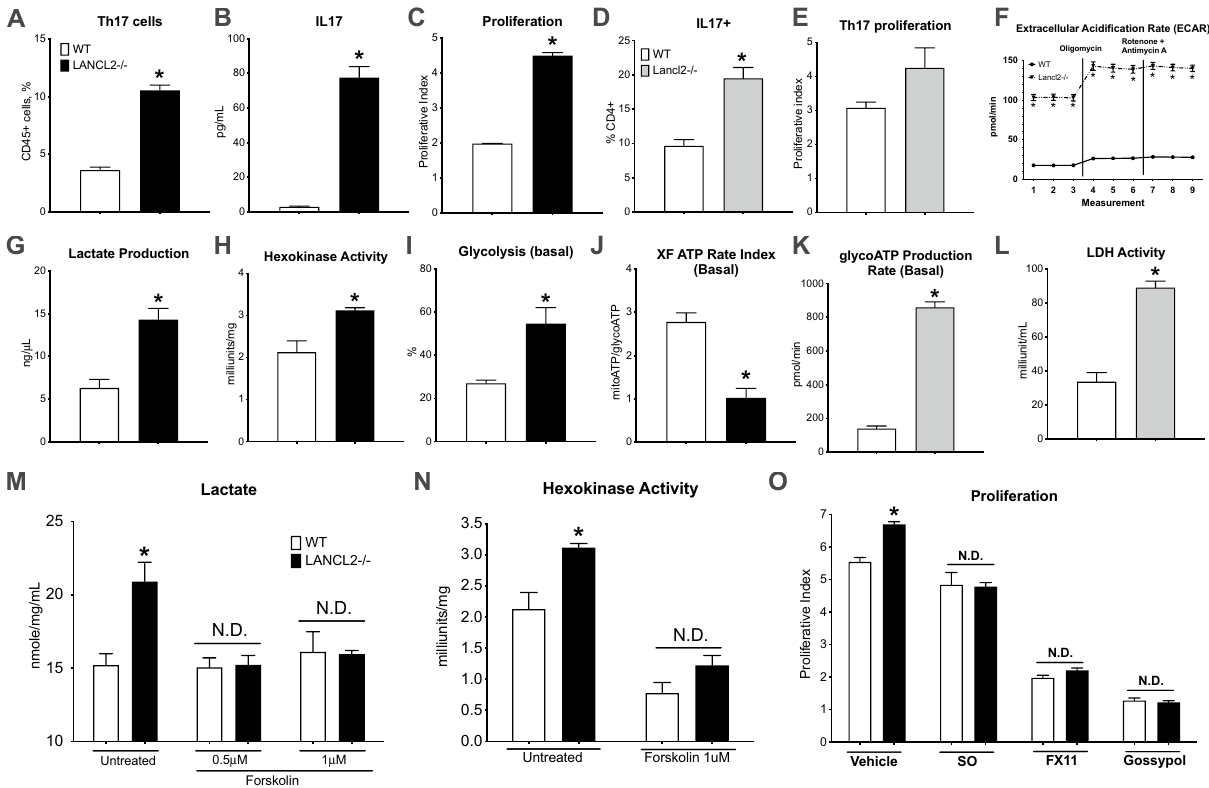
Figure 4. Effects of LANCL2 pathway in CD4+ T cells and Th17 cells. CD4+ T cells and naïve T cells from WT and LANCL2 −/− spleens were isolated and cultured for 48 h. Naïve T cells were differentiated to Th17 cells. In CD4+ T cells, proportion of Th17 cells ( A ) were measured using flow cytometry analysis, IL17 ( B ) secretion was quantified through cytokine bead array, and proliferation ( C ) through CFSE staining. In Th17 differentiated cells, percentage of IL17+ cells ( D ) and Th17 proliferation ( E ) were assessed through flow cytometry analysis. Metabolic assessment was also conducted using Agilent Seahorse ( F , I–K ) and commercial metabolic kits ( G , H , L–N ). Extracellular Acidification Rate ( F ), ATP production from glycolysis ( K ) and LDH activity ( L ) were assessed in Th17-differntiated cells. Lactate production ( G ), hexokinase enzymatic activity ( H ), percentage of utilization of complete glycolytic pathway ( I ) and XF ATP Rate Index (mitoATP/GlycoATP, J ) were measured in CD4+ T cells. CD4+ T cells were treated with the adenylate cyclase activator Forskolin and lactate production ( M ) and hexokinase enzymatic activity ( N ) were measured using the metabolic kits. CD4+ T cells were also treated with sodium oxamate, FX11, and gossypol (three inhibitors of LDH activity) and proliferative index ( O ) was assessed by CFSE staining and flow cytometry analysis. * P ≤